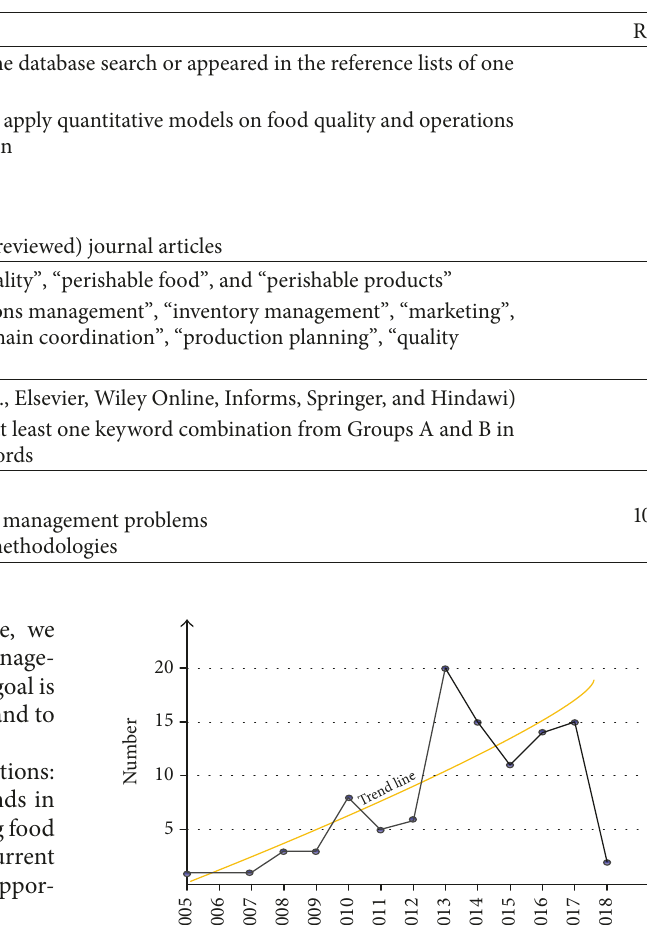
Table 1: Searching guidelines and results.